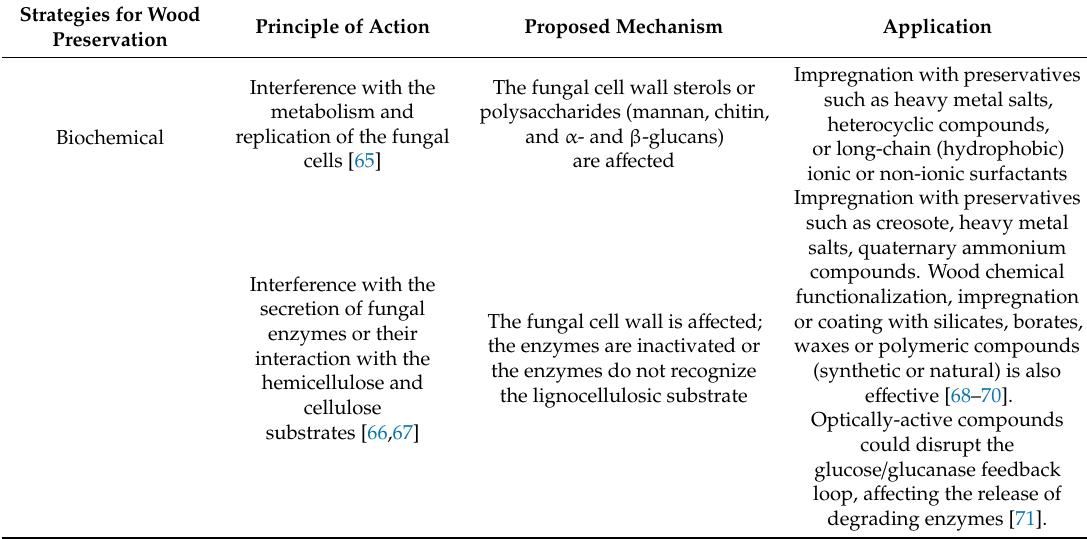
Table 2. Strategies employed for wood